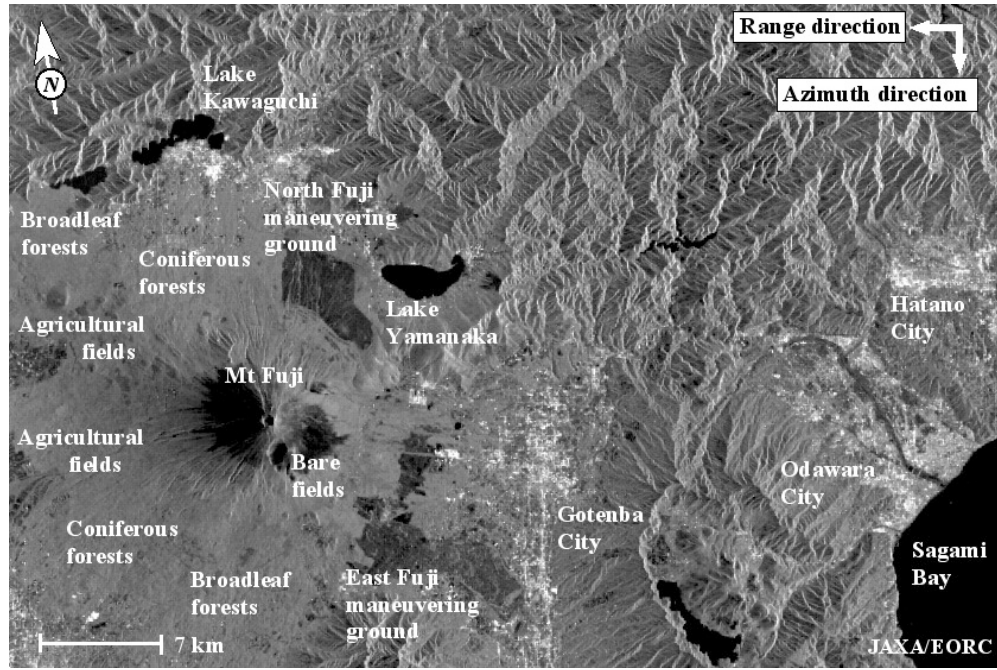
Figure 8. ALOS-PALSAR L-band SAR image around Mt. Fuji, where the scene center is approximately at (N: 35.39 ◦ , E: 138.92 ◦ ). The image amplitude differs depending on the normalized backscatter radar cross section (NRCS) of the surface, where smooth surfaces of lakes and bare soils have very small amplitude, vegetation fields have slightly larger amplitude, rather large amplitude can be seen in forests, and cities with buildings appear to have very large amplitude. The effects of geometrical distortion can be seen in mountain areas of high relief. (Courtesy of